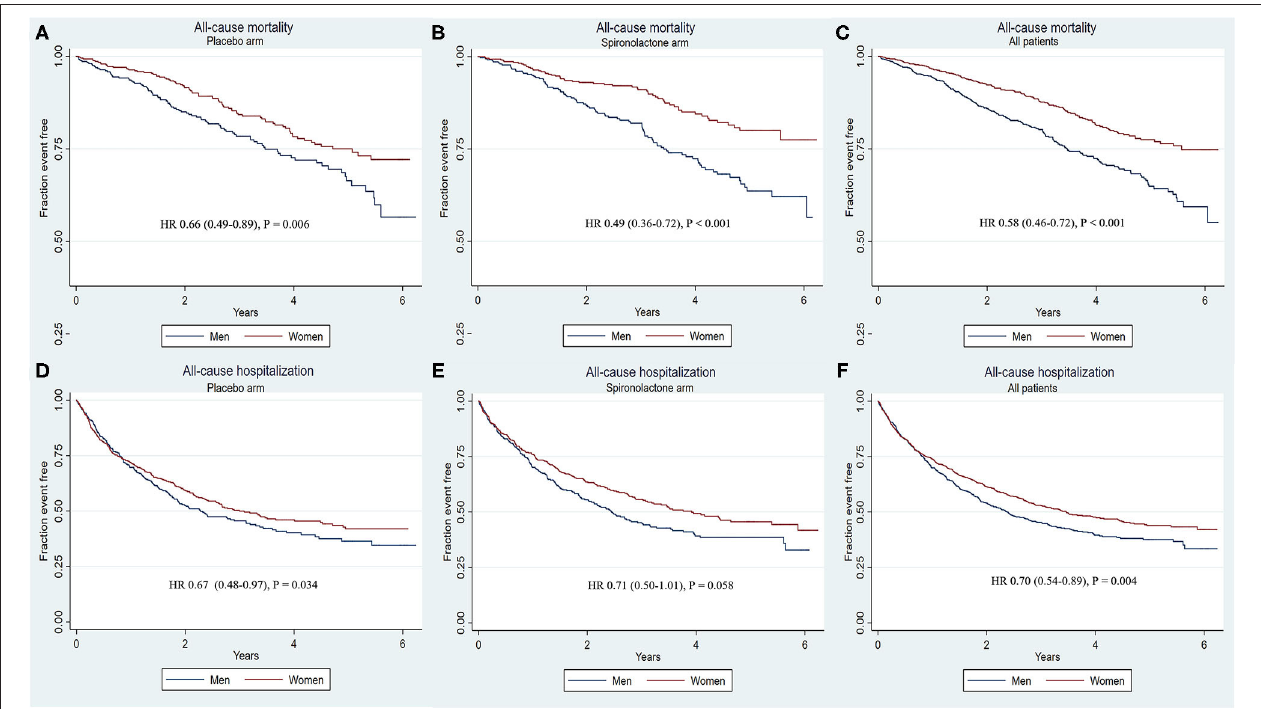
FIGURE 2 | Kaplana–Meier survival curves for secondary outcomes and components stratified by sex according to treatment. Women were associated with a significantly reduced likelihood of all-cause mortality in the placebo arm, spironolactone arm, and all patients. No significant result was observed for all-cause hospitalization. (A–C) All-cause mortality in placebo arm, spironolactone arm, all patients; (D–F) All-cause hospitalization in placebo arm, spironolactone arm, all